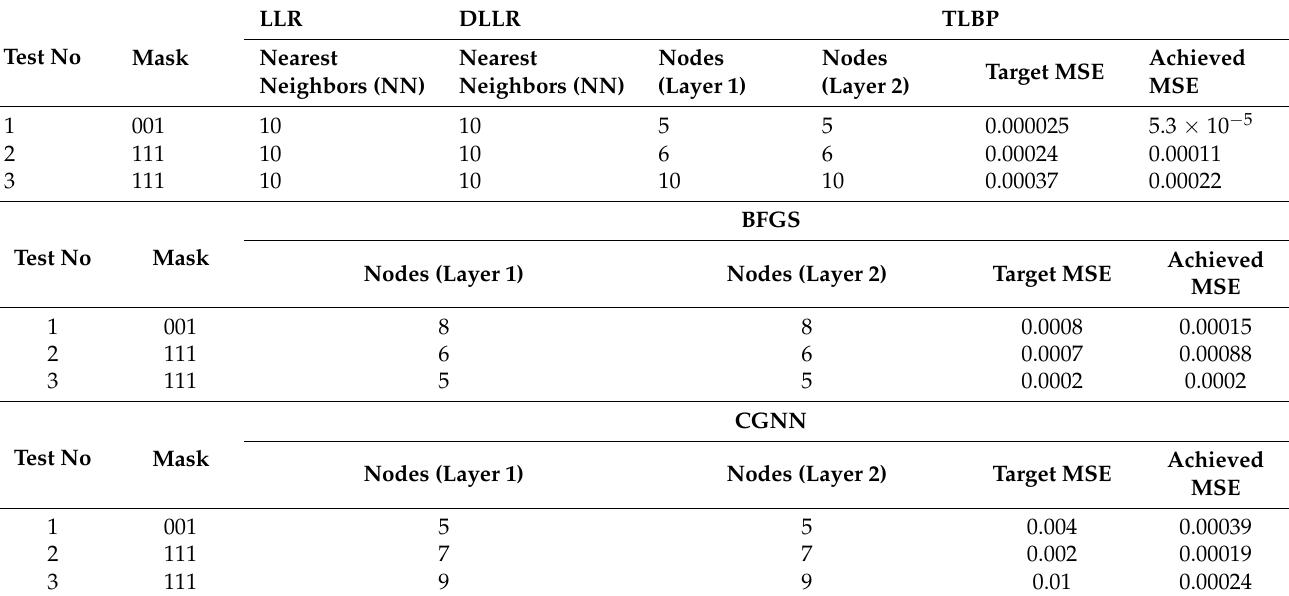
Table 2. DLLR, TLBP, CGNN and BFGS model